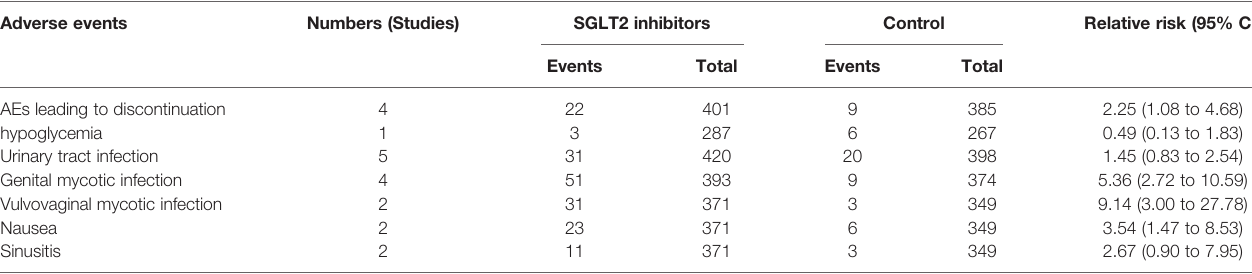
TABLE 3 | Adverse events reported in all included studies.